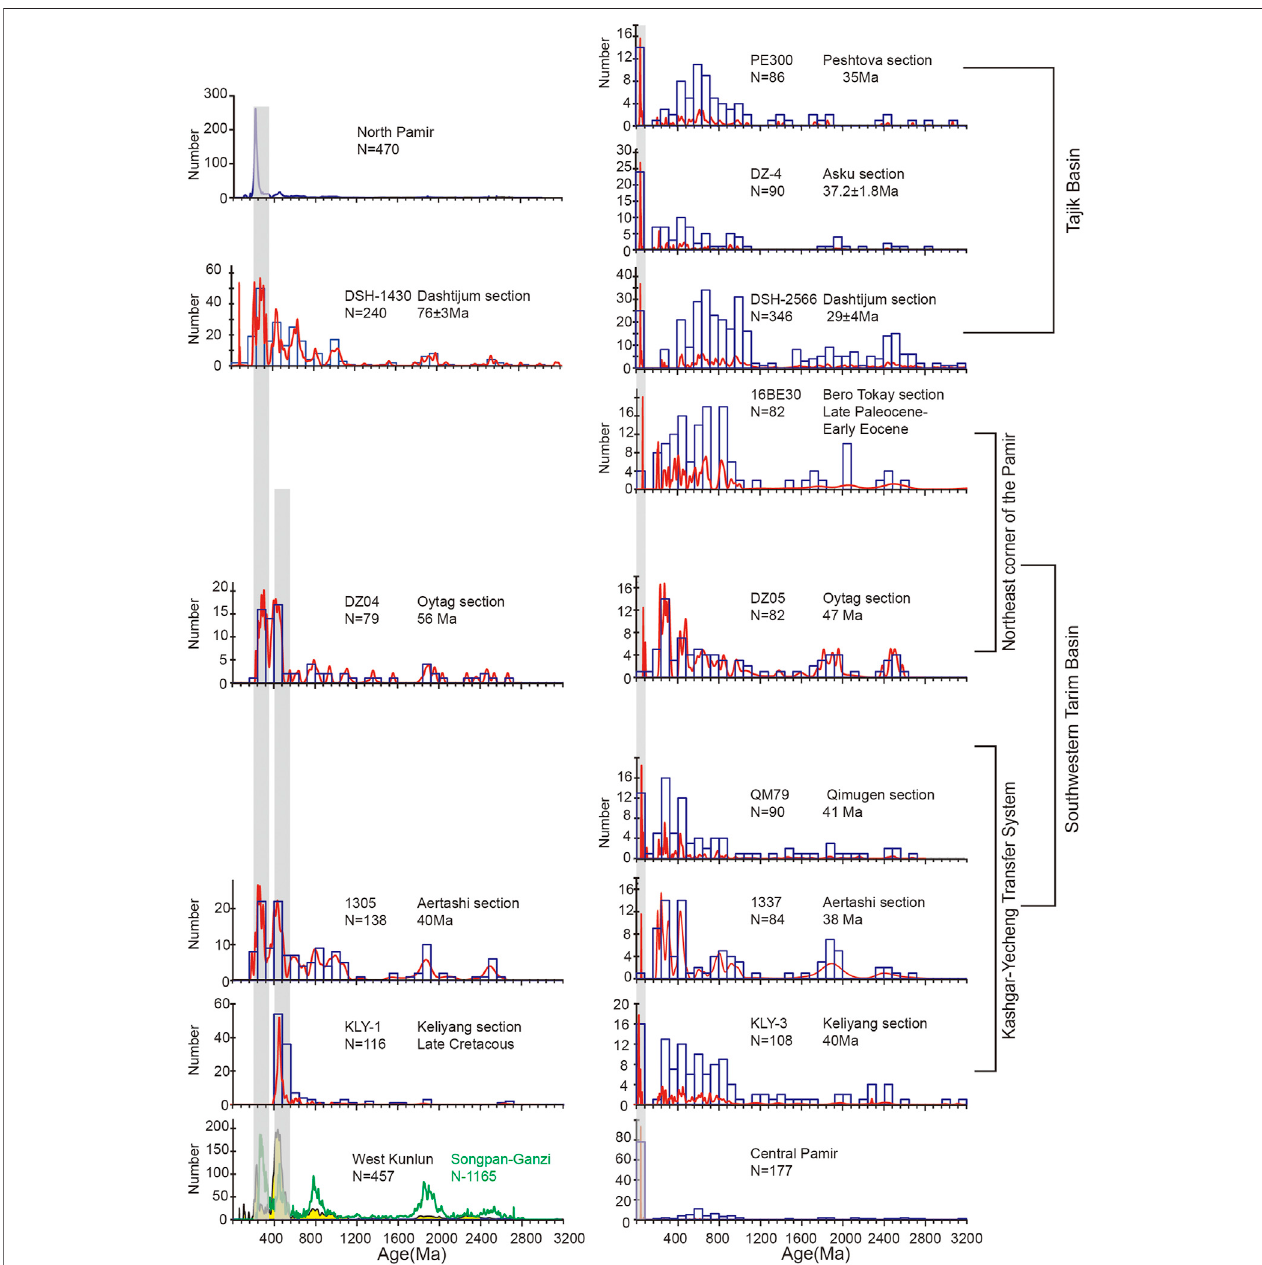
FIGURE8| Characterizationofsourceregionsandprobabilitydensity plotsoftheBeroTokay,Qytag,Qimugen, Aertashi,KeliyangsectionsintheTarimBasinand Dashtjum, Asku, Peshtova sections in the Tajik Basin. Data from the Oytag, Qimugen, Aertashi, Dashtjum, Asku and Peshtova sections are modi fi ed from Sun et al. (2016b),Zhangetal.(2019),Blayneyetal.(2016),Chapman etal.(2019),Sun etal.(2020),and Carrapaet al.(2015).Detrital zirconU/Pbage plotsfrom NorthPamirare modi fi ed from (Carrapa et al., 2014; Blayney et al., 2016; Rittner et al., 2016). Detrital zircon U/Pb age plots from West Kunlun are modi fi ed from Blayney et al. (2016).DetritalzirconU/PbageplotsfromSongpan-Ganziaremodi fi edfromDingetal.(2013).Shadedbarsmarkpeakagesat400 – 500 Ma,200 – 300 Maand ∼ 45 Ma. The signi fi cant Eocene quasi-synchronous sedimentary provenance changes occurred in both the Tarim and Tajik basins.